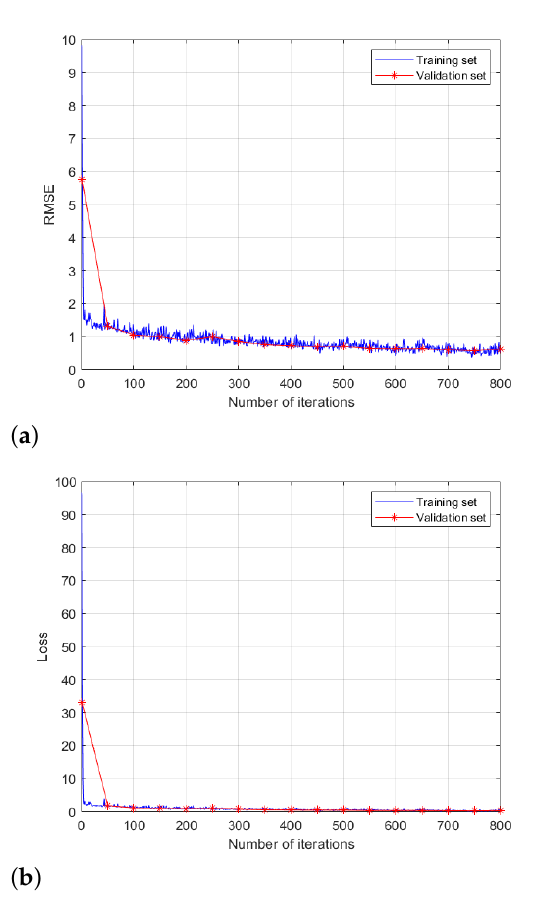
Figure 8. Training and validation of the network: ( a ) RMSE ( b ) loss